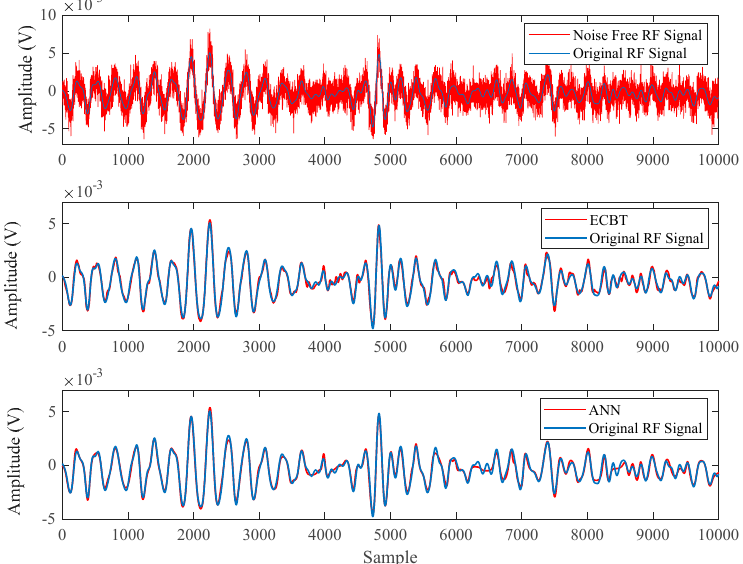
Figure 14. Denoising of RF signal, combination of ‘sharp point’ and ‘internal void’ types, PSNR = 1.